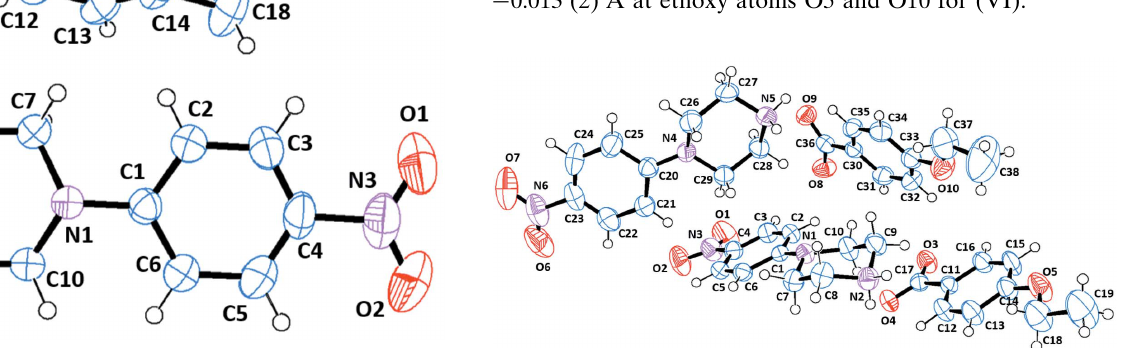
Figure 4 The independent components of compound (IV) showing the atom- labelling scheme and the hydrogen bonds, drawn as dashed lines. Displacement ellipsoids are drawn at the 50% probability level.